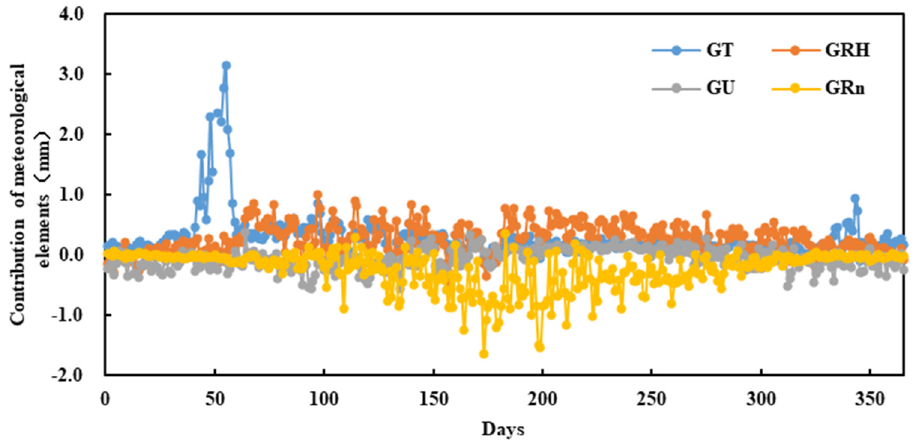
Figure 6. Contributions of the four meteorological factors on daily scales to changes in reference evapotranspiration (ET 0 ). G RN , G T , G RH and G U are the average contributions of net radiation, temperature, relative humidity and wind speed, respectively.